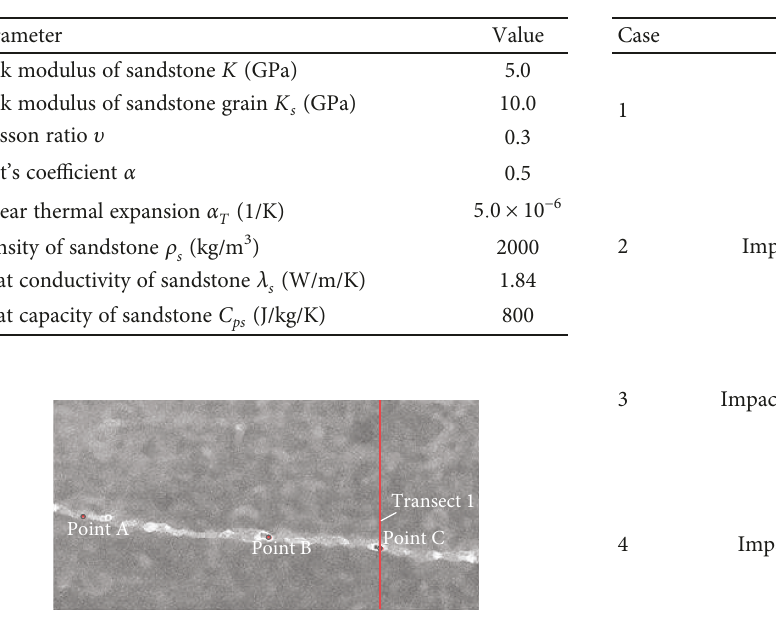
Figure 9: CT image of a single arti fi cial fracture in sandstone.